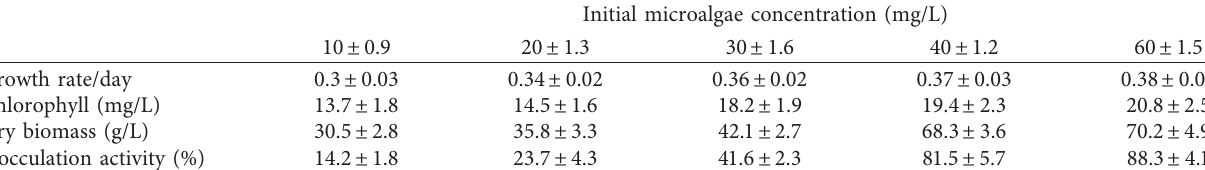
Table 2: The growth rate, chlorophyll content, and flocculation